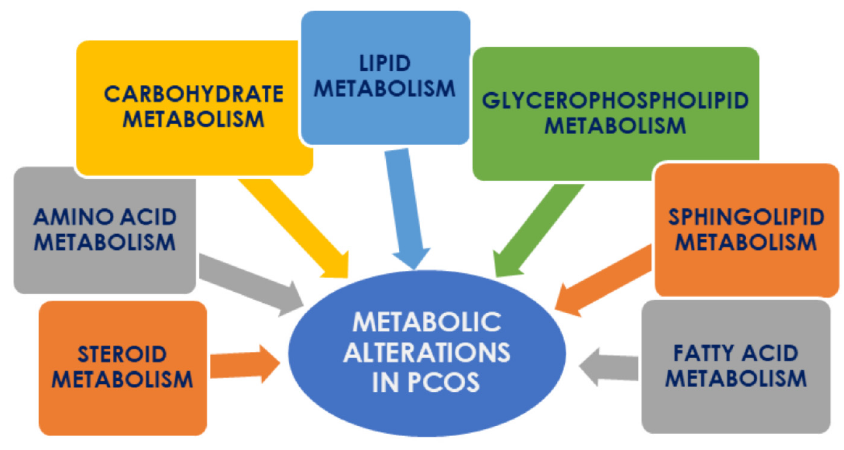
Figure 3. The main biochemical pathways disturbed in PCOS.